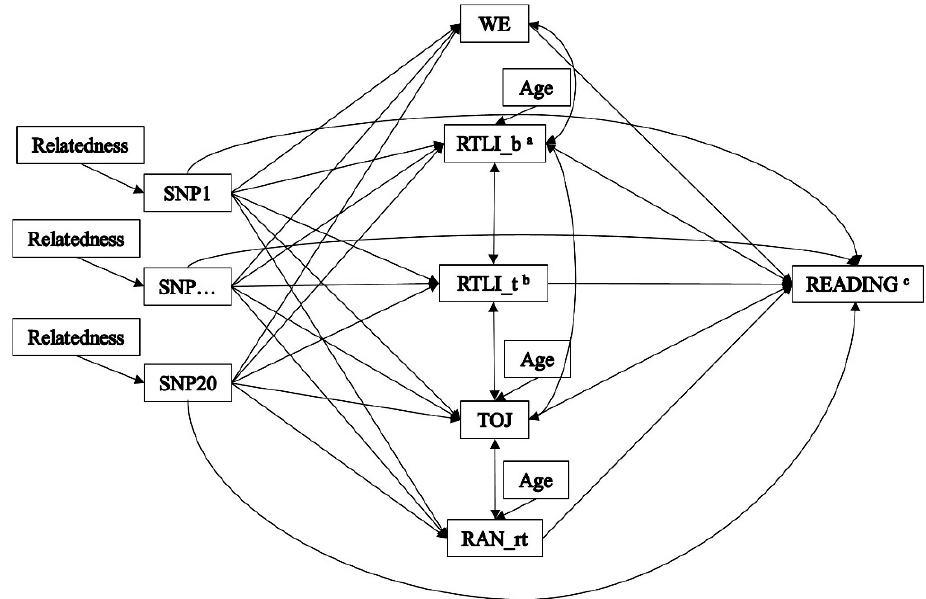
Figure 1. The multiple-predictor / multiple-mediator model. WE = multisensorial warning e ff ect; RTLI_b = rotating-tilted-lines illusion, slope; RTLI_t = rotating-tilted-lines illusion, threshold; RAP = rapid auditory processing; RAN_rt = rapid automatized naming of colors, reaction time. Family relatedness was controlled as clustering variable upon the SNPs’ e ff ects. We also controlled for the correlations between RTLI_b, RAP and RAN_rt, and “age”, between between WE and RTLI_b, between RAP and RTLI_b, RTLI_t and RAN_rt, and between RTLI_b and RTLI_t (Table S2). a It refers to values after logarithm transformation. b It refers to values after square root transformation. c It refers to the average among text-, single word and single non-words reading tasks (both accuracy and